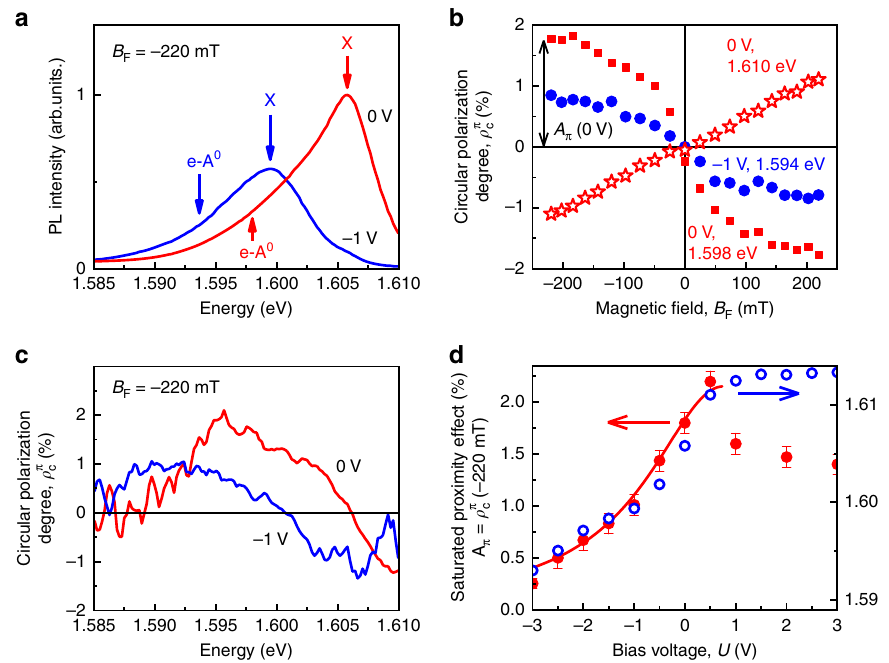
Fig. 2 Polarization spectroscopy in the cw regime. a PL spectra at U = 0 (red) and − 1 V (blue). b Magnetic fi eld dependences of the circular polarization B ð Þ measured at U = 0 V, ħ ω = 1.598 eV (red squares), U = − 1 V, ħ ω = 1.594 eV (blue circles), and U = 0, ħ ω = 1.610 eV (red stars), using degree ρ π PL PL PL F c linearly polarized excitation. The arrow indicates the amplitude A π (0 V) of the FM proximity effect for U = 0 at 1.598 eV detection energy. c Spectral dependences of ρ π for U = 0 V and − 1 V. d Amplitude A π ( U ) of the FM proximity effect (red circles) and the energy of the PL peak ħ ω max ( U ) (blue circles) c as functions of the gate voltage. The red curve is a fi t using Eq. (8) with A = 2.2%, U 0 = 0.8 V, and U 1 = 1.8 V. Excitation was done with photon energy 1.691 eV (below the band gap of the (Cd,Mg)Te barriers) using a power density of 4 W cm − 2 . In all cases the magnetic fi eld was B F = − 220 mT (except of ( b )) and temperature T = 2 K. Error bars represent standard